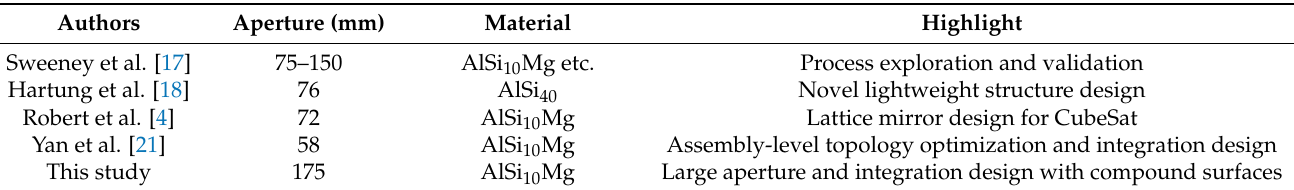
Table 1. Comparison with the other